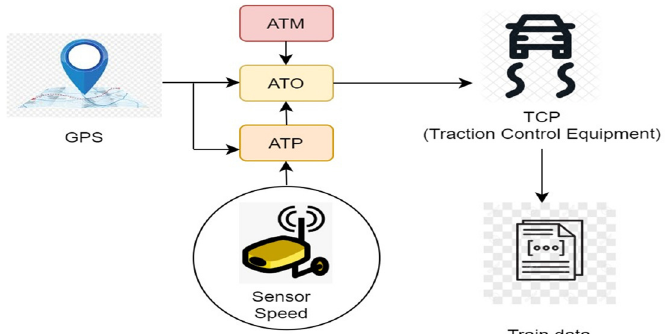
Figure 2: Block diagram of ATO